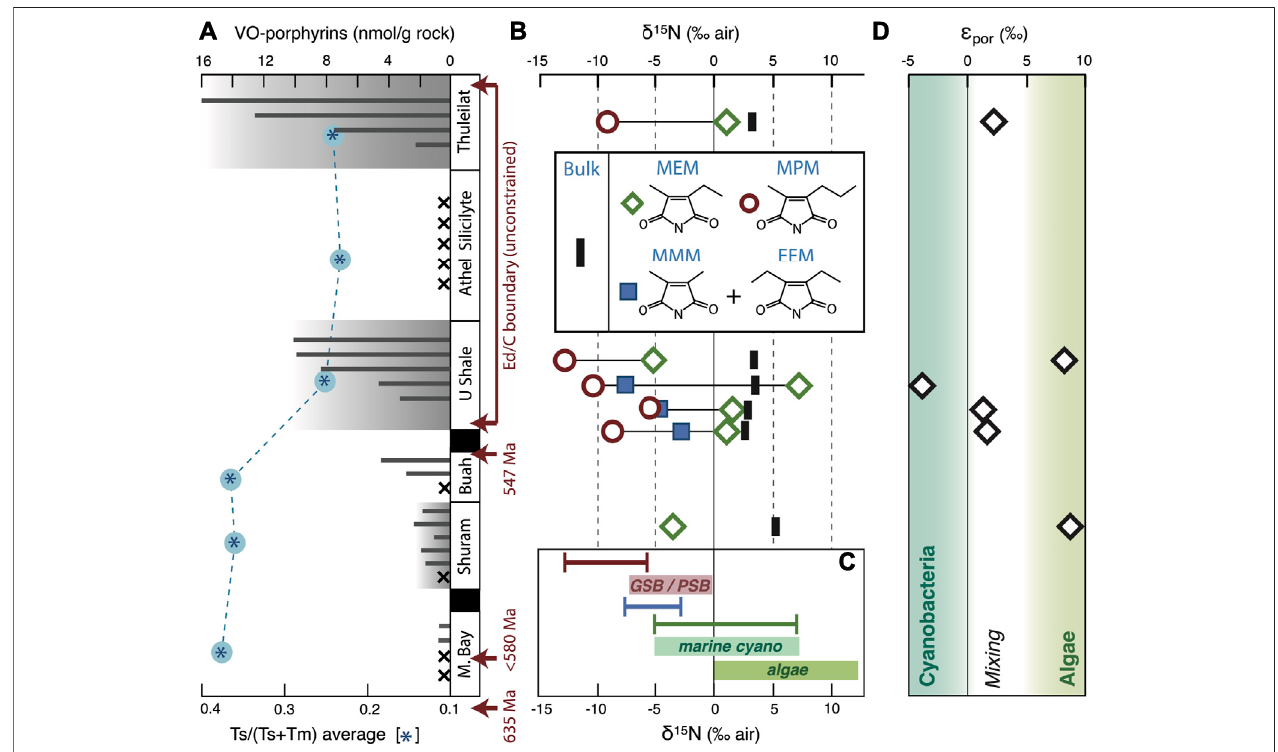
FIGURE5| Porphyrinabundancesandmaleimidenitrogenisotopes. (A) VO-porphyrinabundances(greybars;plottedperstratigraphicunitirrespectiveofexactdepth) decreasewithburialandthermalmaturity(blueasterisks;basedonthehopanoidsTsandTm: Figure6 ).Crossesindicateabsentporphyrins. (B) δ 15 Nvaluesofkerogensand maleimides were determined for six samples only due to concentration and matrix interference. (C) Ranges of observed values (colored lines) and δ 15 N biomass values converted from δ 15 N maleimide basedonknown biosyntheticfractionationduring porphyrinbiosynthesisafter Higginsetal.,2011(annotated boxes)place constraintson nitrogen substrate and assimilatory processes. (D) The kerogen – MEM isotopic offset allows reconstructing the dominant primary producers (Higgins et al., 2011,